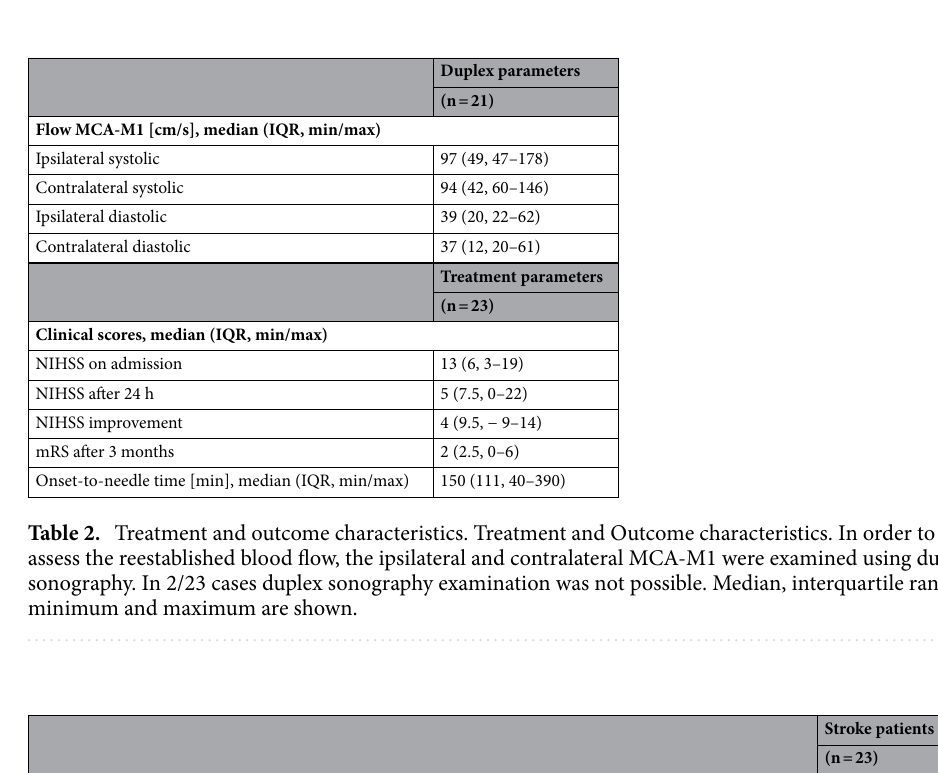
Flow MCA-M1 [cm/s], median (IQR, min/max)